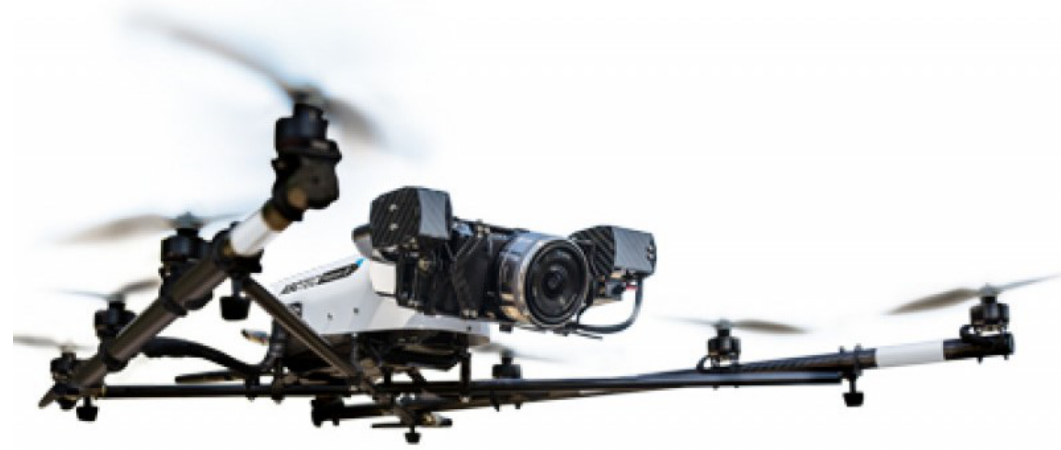
Figure 3. AscTec Falcon 8 unmanned aerial system (UAS) equipped with a SONY NEX-5 camera.